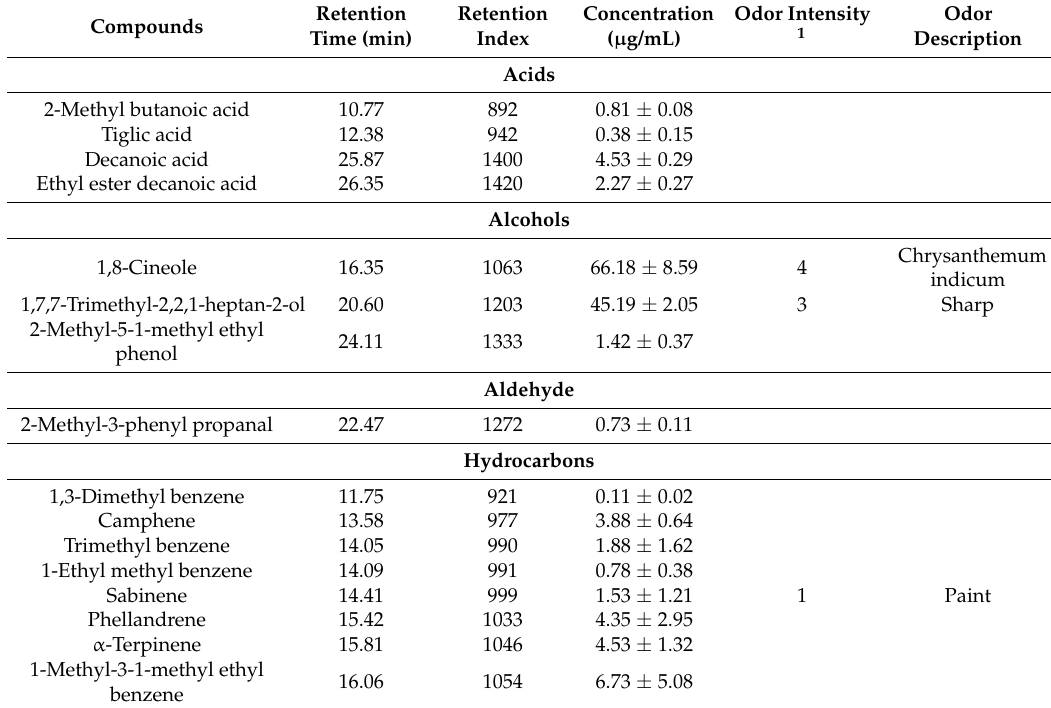
Table 1. Volatile organic chemicals (VOCs) in Chrysanthemum indicum Linn é .